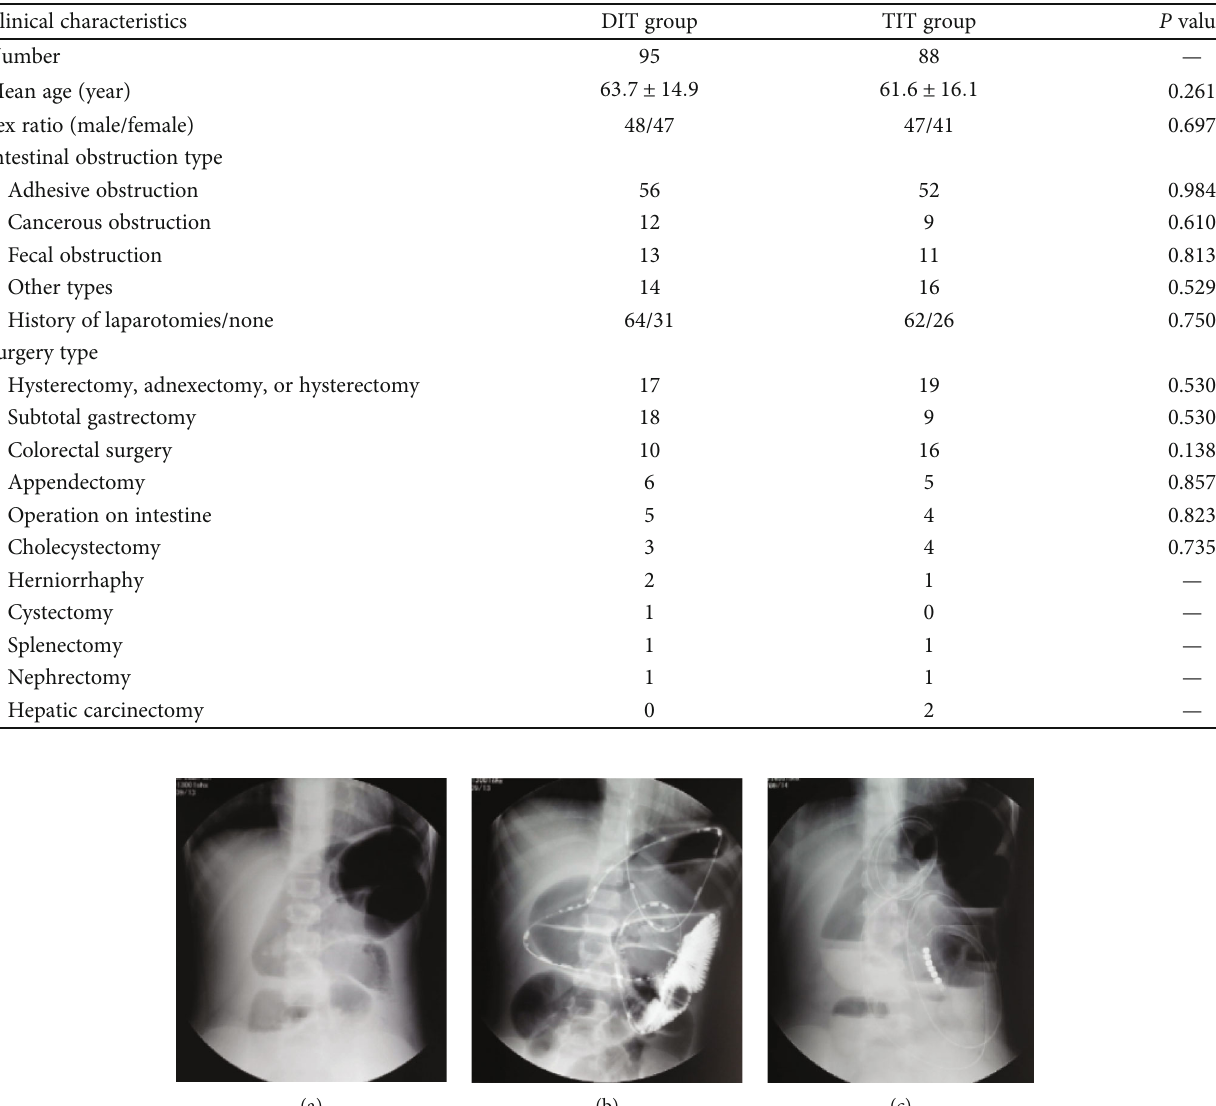
Table 1: Baseline clinical characteristics of patients between the two groups.